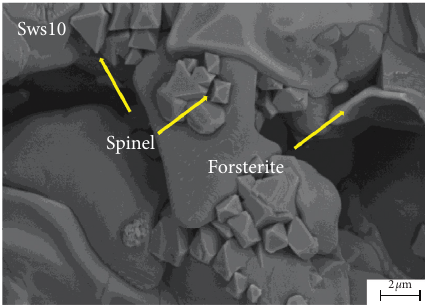
Figure 7: SEM picture of inner hole morphology (3000 ×